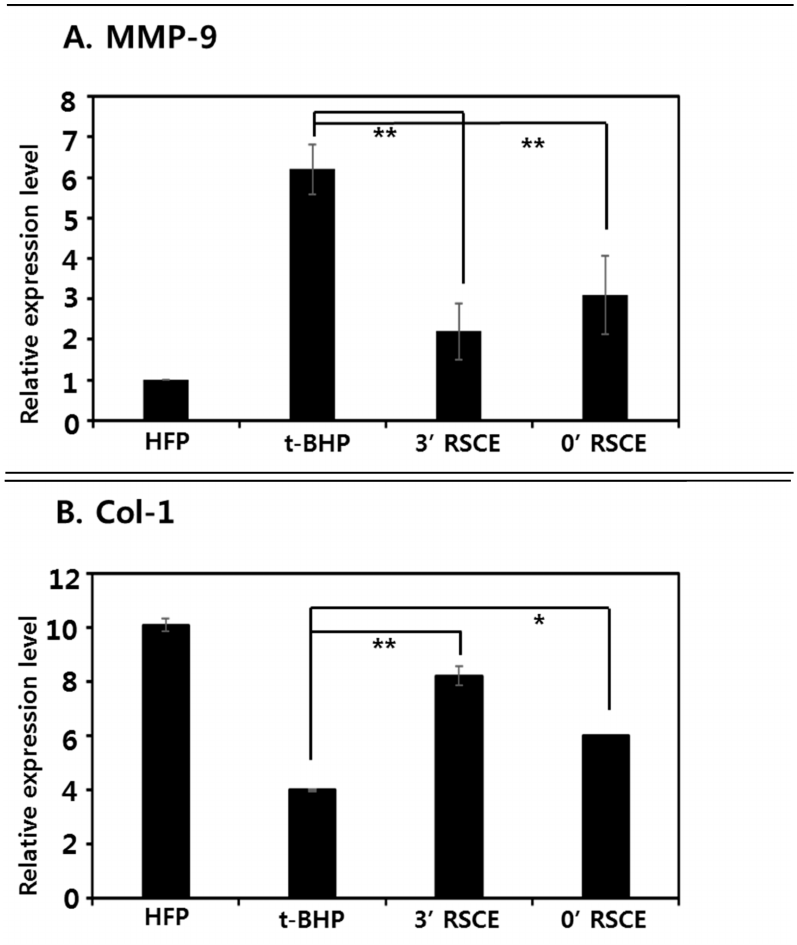
Figure 7. Quantitative RT-PCR analysis of anti-aging-related genes MMP-9 and Col-1 after treatment of RSCE in HFB. ( A ) MMP-9 ( B ) Col-1. All measurements were made in more than 3 replicates. * p < 0.05; ** p <